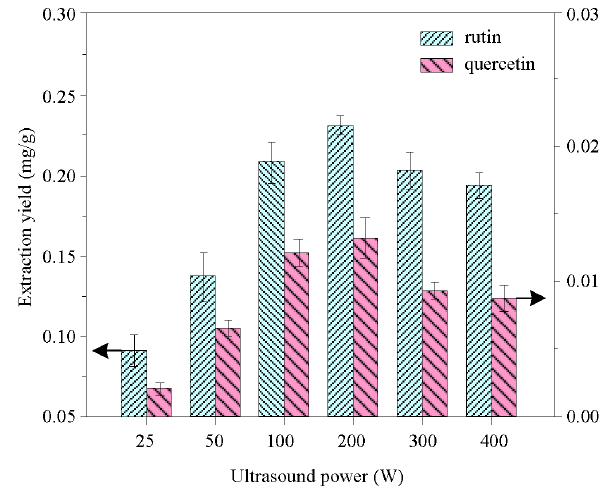
Figure 6. Effect of ultrasonic power using 60% concentration of ethanol solution with 40 mL/g of ratio at 30 °C and 80 kHz for 30 min on the extraction of quercetin and rutin.